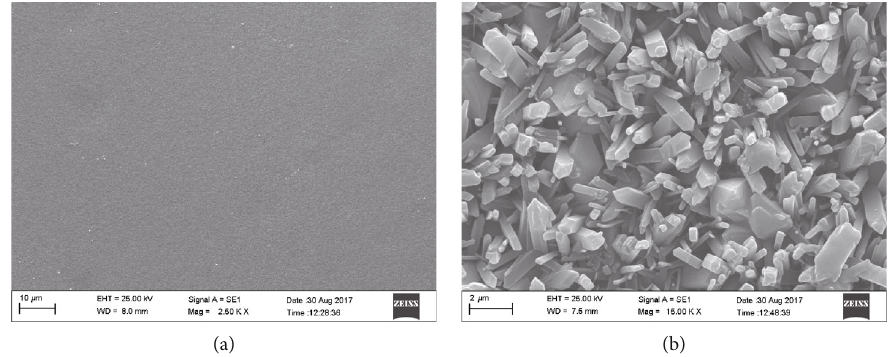
Figure 9: SEM images of the PIM surfaces of before (a) and after (b) Zif-8 deposition.